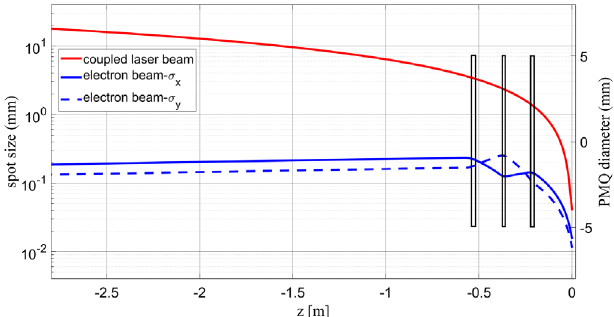
FIG. 4. Laser and electron beam propagation through the PMQ triplet. The laser and electron beam is plotted from the position of laser in-coupling mirror (2.8 m behind the plasma cell) until the entrance of the plasma cell. To the scale dimension and position of optimized quadrupole triplet are also shown.